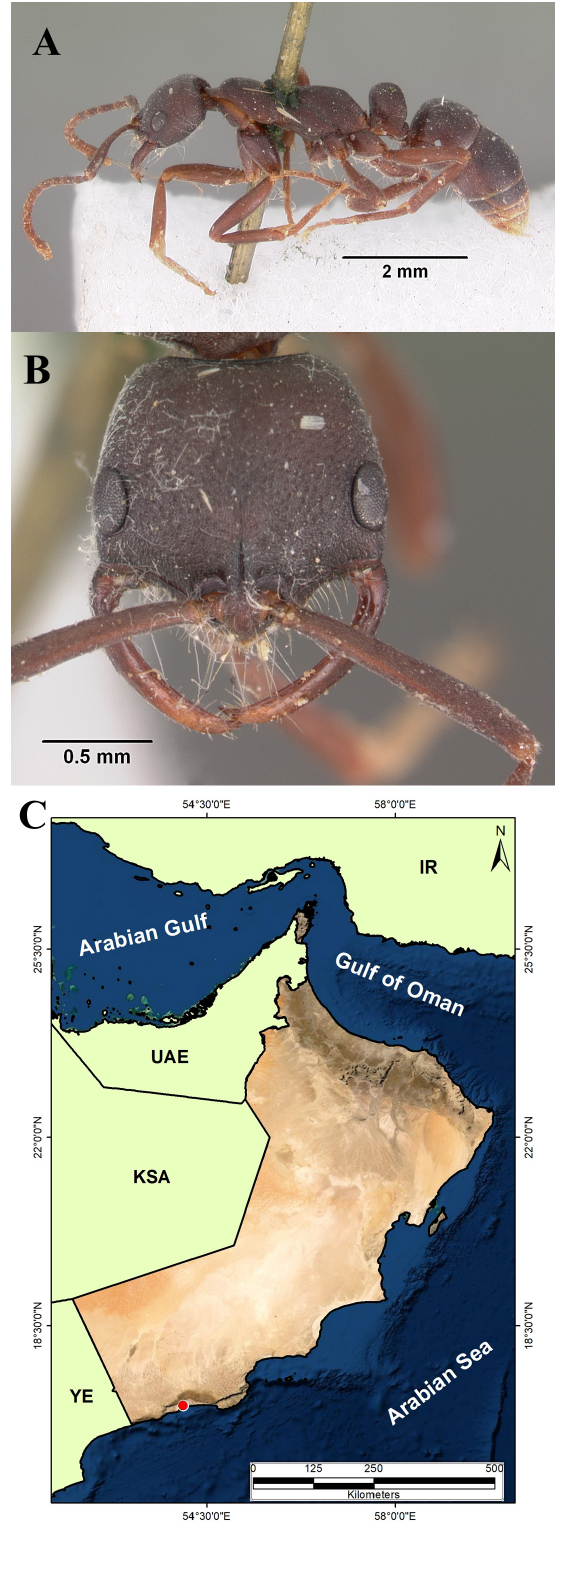
Fig. 55. Leptogenys maxillosa (Smith, 1858), syntype, worker (CASENT0102266, AntWeb.org (April Nobile)). A . Body in profile. B . Head in full-face view. C . Distribution